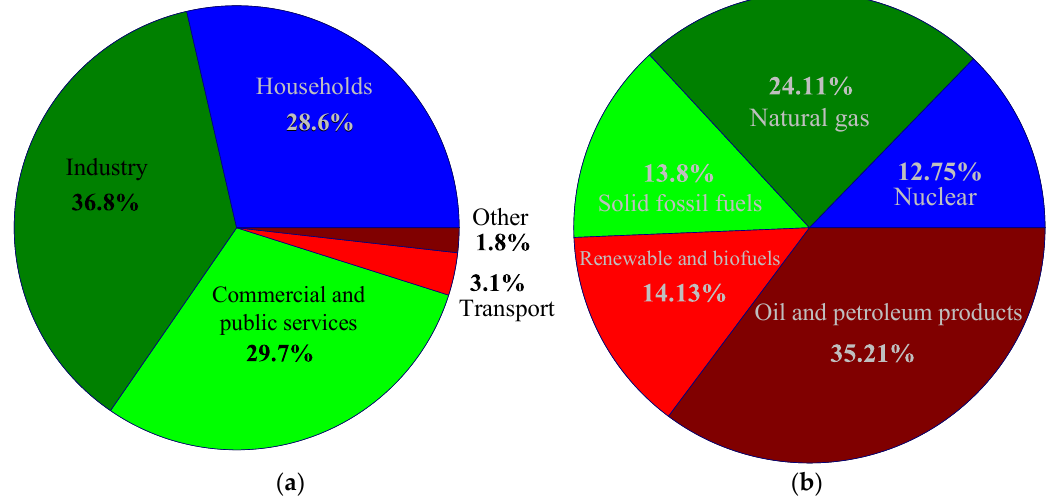
Figure 1. Classification of final electricity consumption in 2017 ( a ) by sector and ( b ) primary energy consumption in 2017 by fuel type in the case of EU-28.